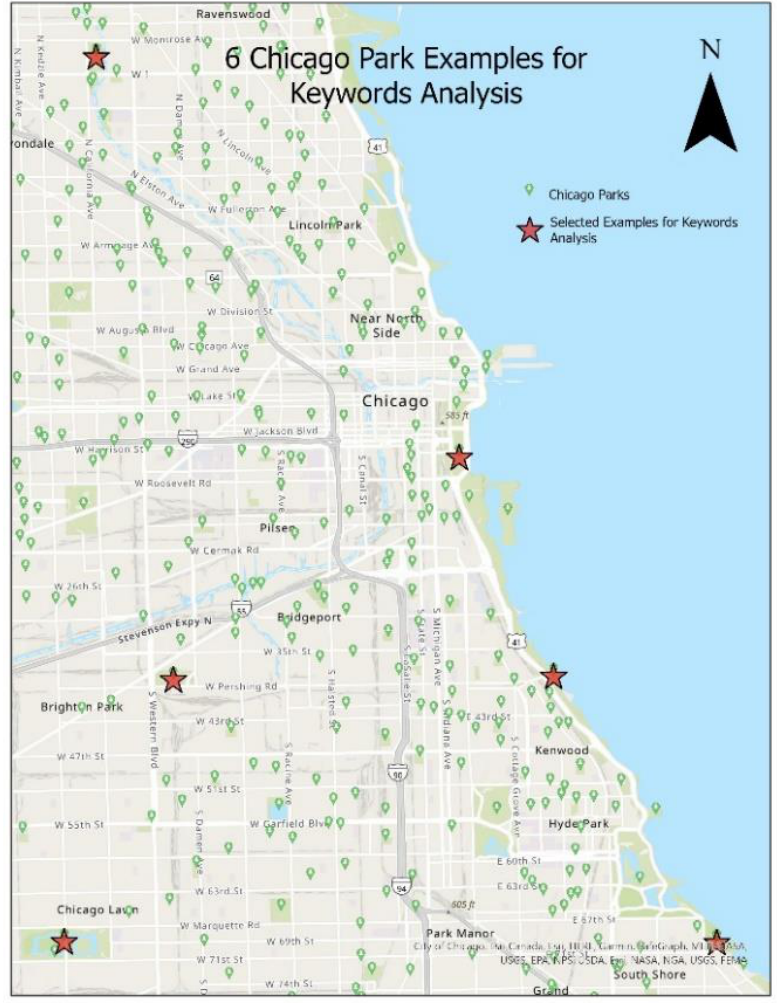
Figure 10. Distribution of 6 manually selected parks for keywords